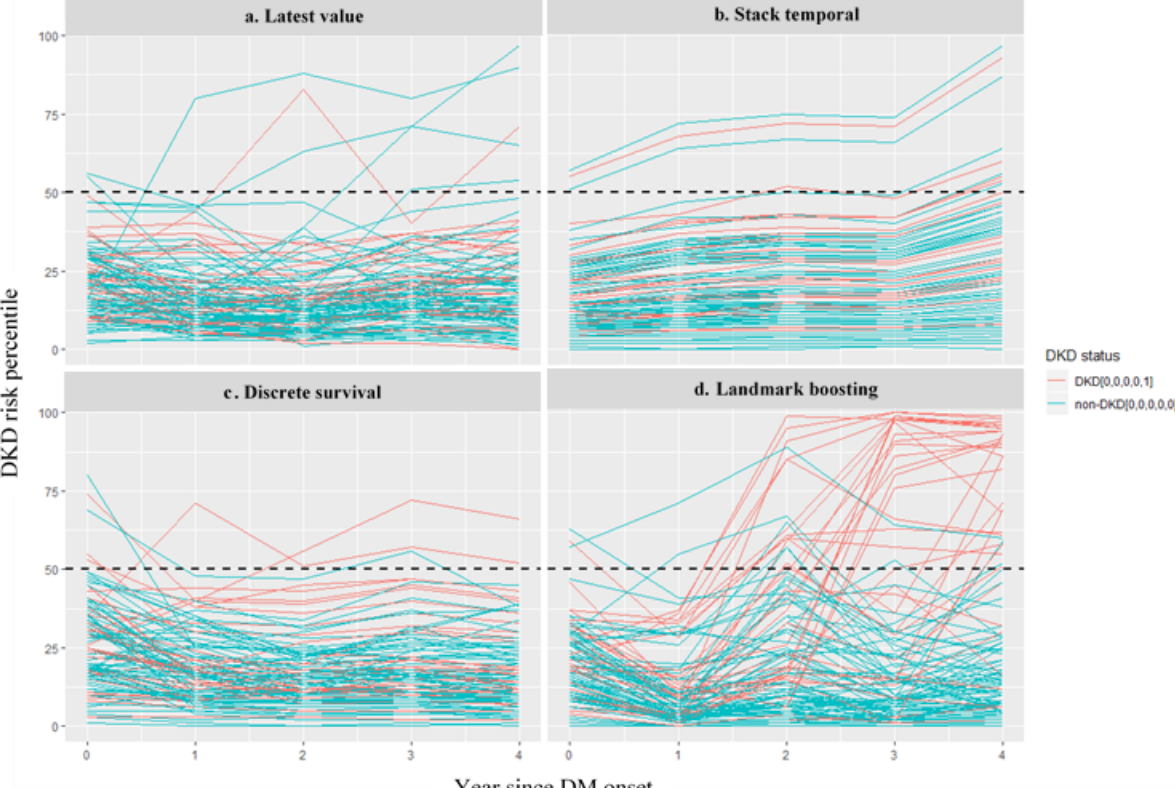
Figure 7. A visualization of predicted diabetic kidney disease (DKD) risk over landmark time. Risk percentiles (ie, normalized risk scores) against landmark time for a sample of patients. Each red line represents patient who finally progressed to DKD, whereas each green line represents patient who did not. DM: diabetes